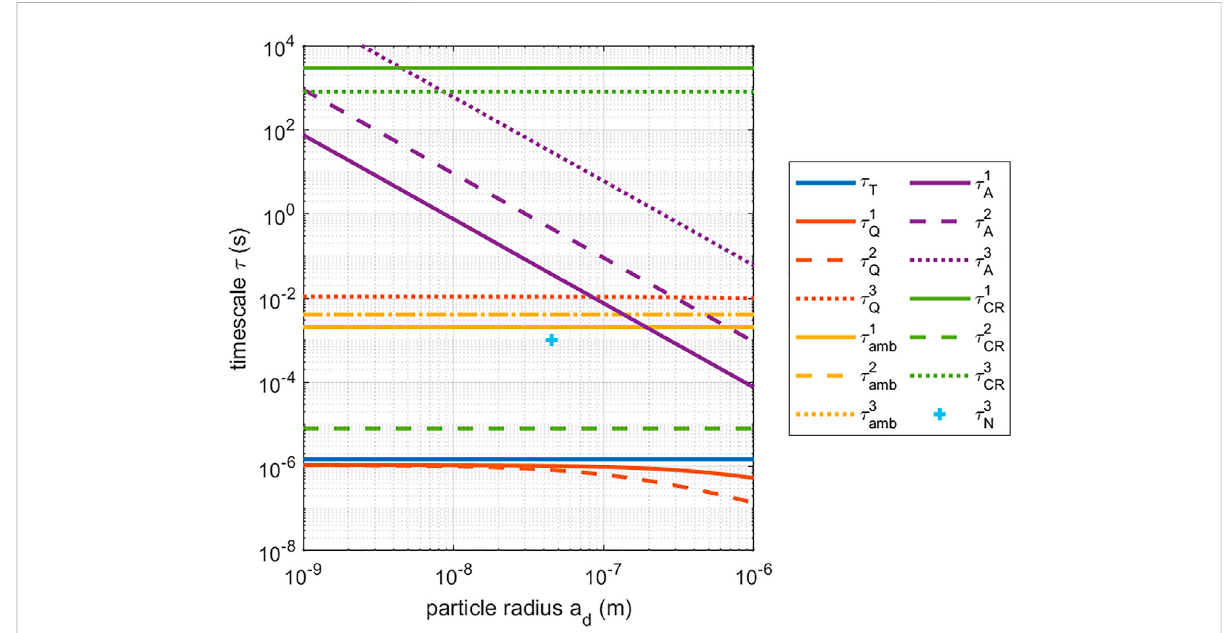
FIGURE 1 Timescales τ (s)asafunction ofparticle radius a d (m).The timescaleshave beenevaluatedfor three differentconditions.Superscript 1(phase 1):